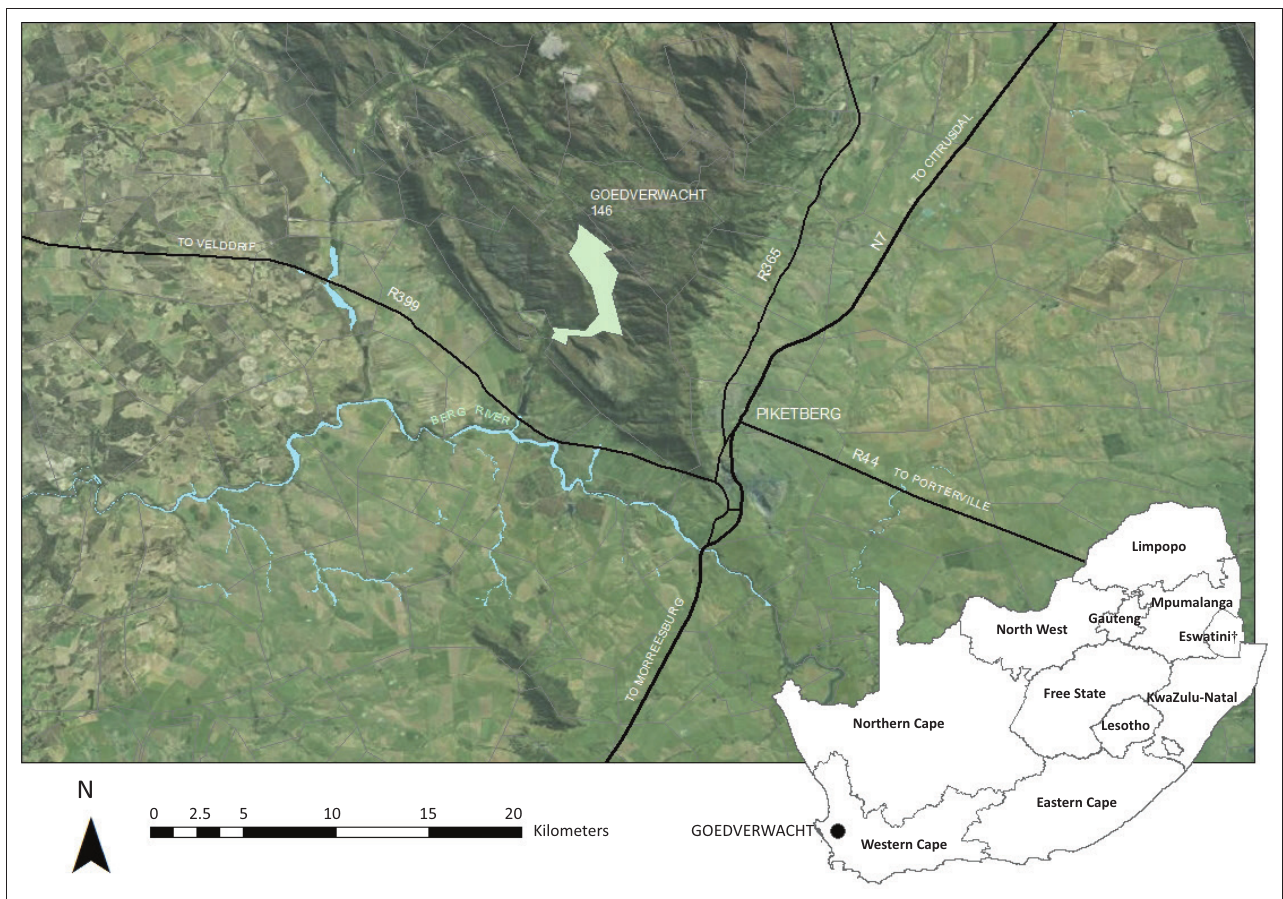
FIGURE 1: Location of Goedverwacht Moravian Mission